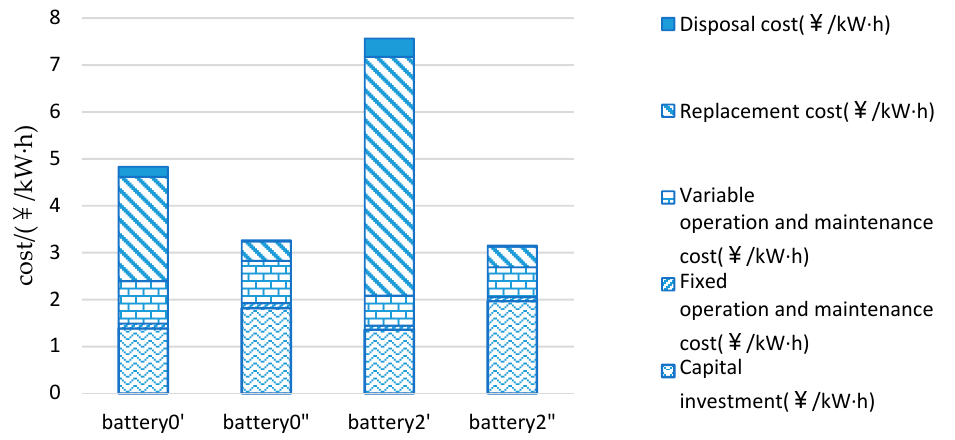
Figure 12. Life-Cycle Cost (LCC) per kW · h comparison before and after the second-stage optimization.